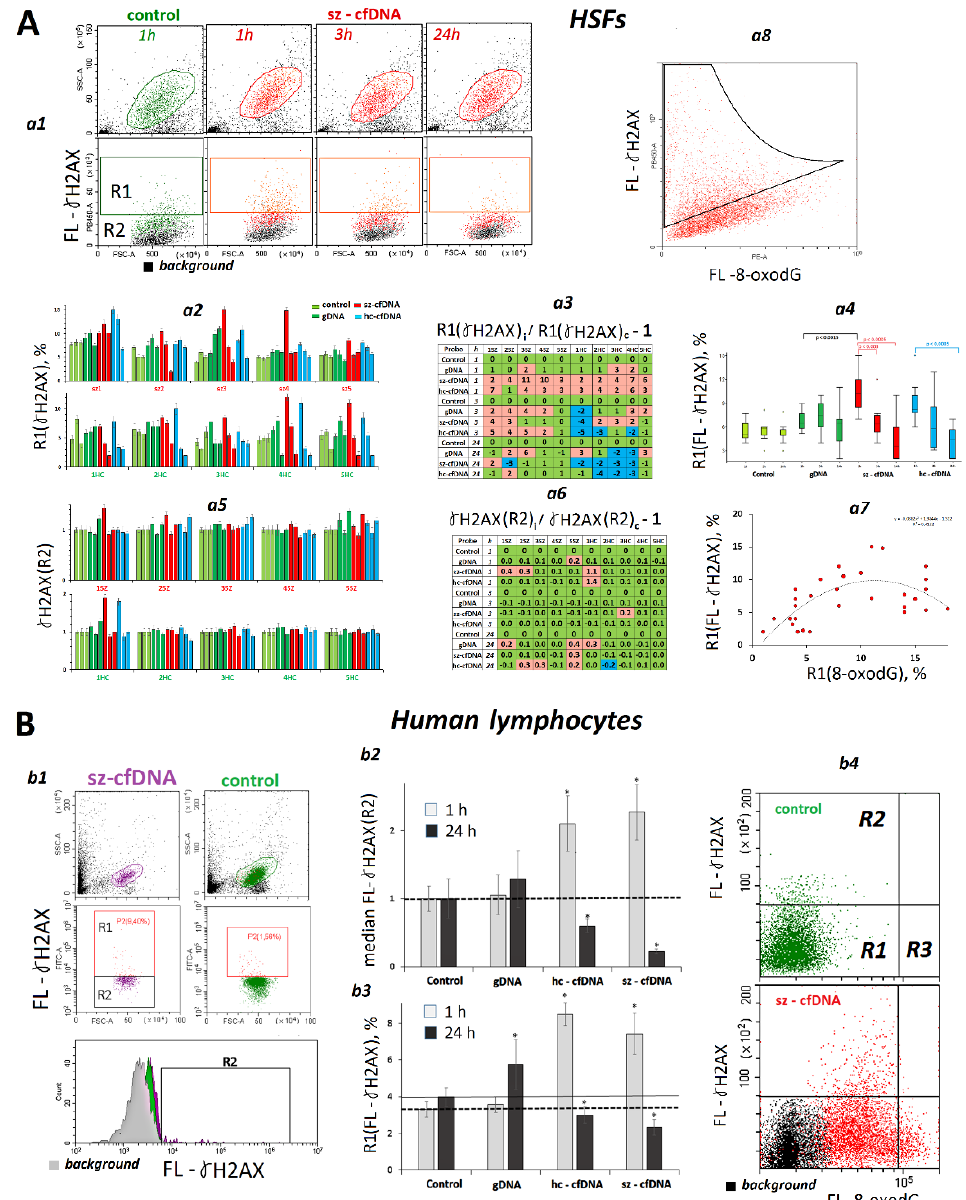
Figure 6 . The influence of the DNA samples on the γ H2AX levels in HSFs and PBL. ( A ). a1 — The most typical examples of the γ H2AX assay with FCA in HSFs. The data from the device are given for sz-HSF3. a2 — Proportion of R1( γ H2AX) fraction cells. a3 — Analysis of relative changes